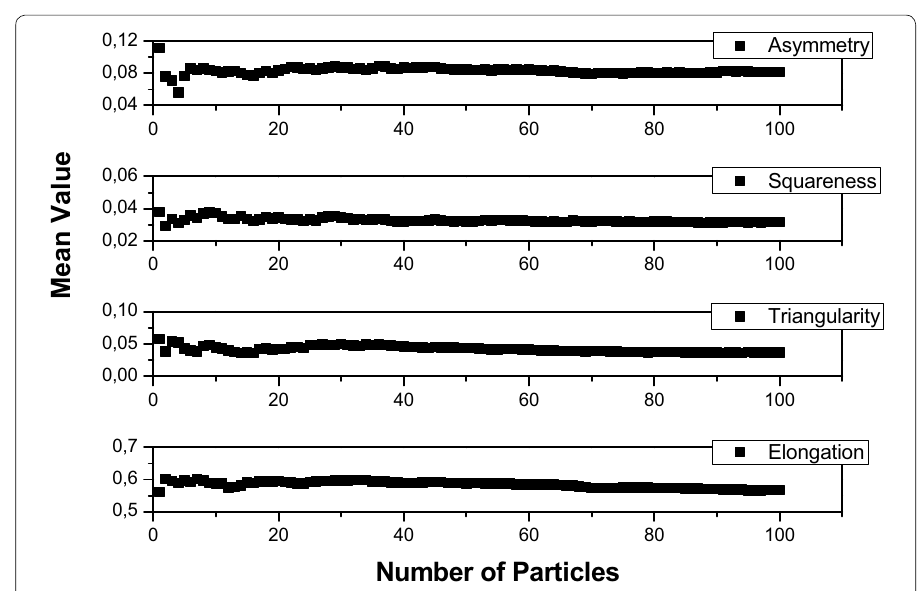
Fig. 9 Asymptotic analysis to determine required number of particle profiles